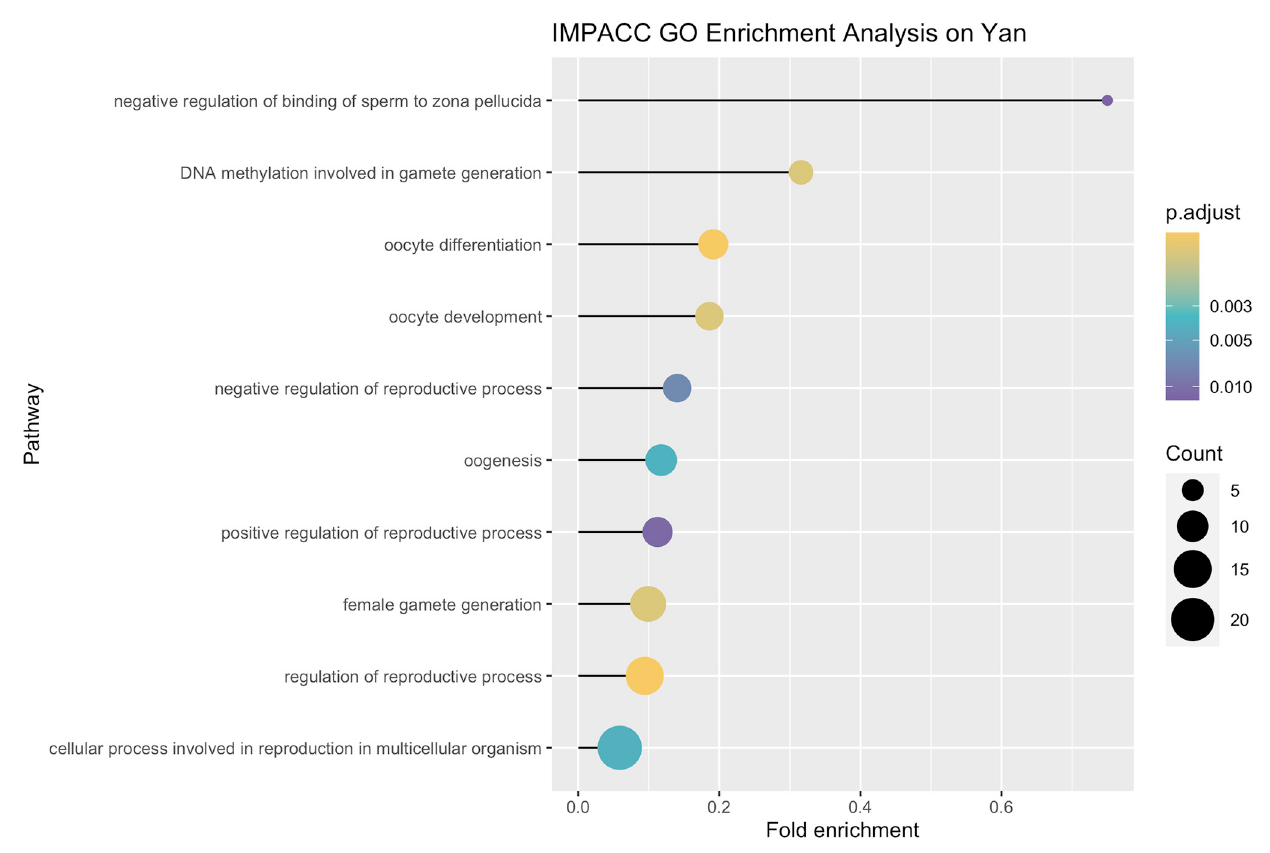
Fig 4. Top 10 pathway of GO enrichment analysis using the differentially expressed genes identified by IMPACC in Yan data set, with information on adjusted p-values, fold enrichment and count.